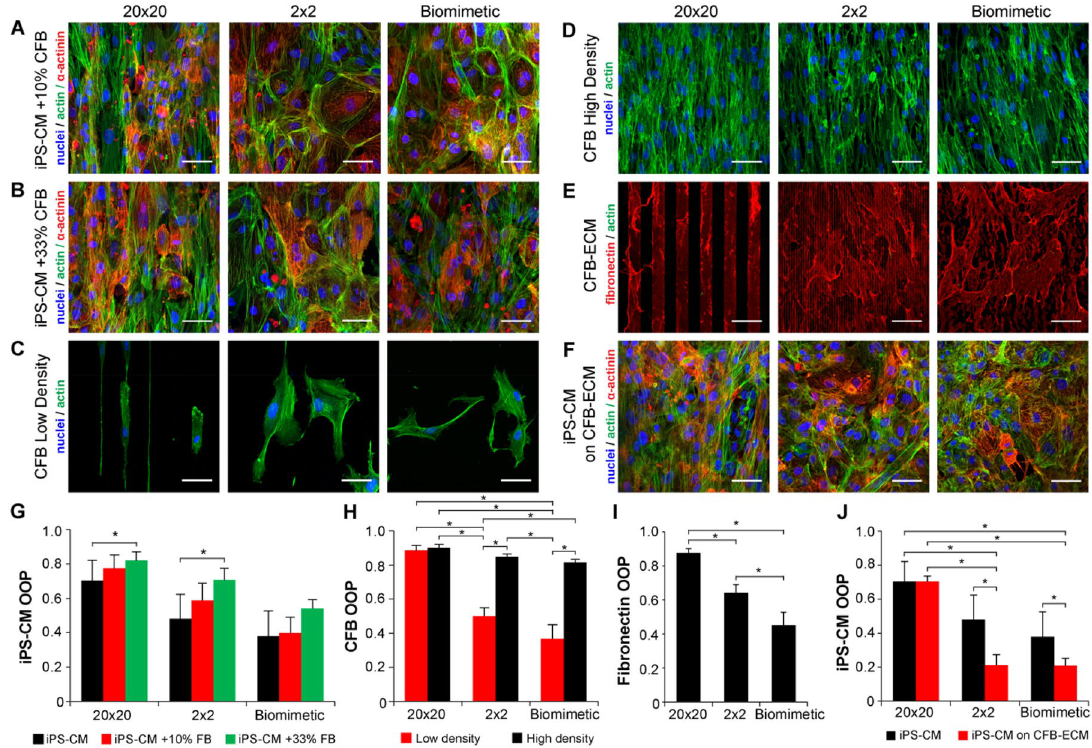
Figure 5. Assessing the role of CFBs on the alignment of iPS-CMs as a function of the fibronectin micropattern. ( A ) Representative images of iPS-CMs with 10% CFBs on the fibronectin micropatterns. CFBs can be distinguished from cardiomyocytes by the lack of α-actinin (red) staining. ( B ) Representative images of iPS-CMs with 33% CFBs on the fibronectin micropatterns. Note the increase in cell alignment relative to ( A ). ( C ) CFBs on the fibronectin micropatterns at low density show pattern-dependent alignment. ( D ) CFBs on the fibronectin micropatterns at high density show alignment on all patterns. ( E ) Fluorescent staining of fibronectin generated by CFBs cultured on the micropatterned substrates, after CFB removal. The 20 × 20 pattern has significantly less CFB-generated fibronectin, likely due to the weaker attachment to the original fibronectin pattern. ( F ) Representative images iPS-CMs cultured on the CFB-generated ECM shown in ( E ). ( G ) Alignment analysis of iPS-CMs on the fibronectin micropatterns with 0%, 10% or 33% addition of CFBs shows increased OOP with increased CFB percentage for all patterns. ( H ) Alignment analysis of CFBs on the fibronectin micropatterns shows that at low density CFB OOP is pattern-dependent, but at high density it is comparably high for all three patterns. ( I ) Alignment analysis of fibronectin generated by CFBs after CFB removal from the surface (CFB-ECM) reveals that for the 2 × 2 and biomimetic patterns, OOP for CFB-ECM is much lower than for the CFB actin cytoskeleton. ( J ) Alignment analysis of iPS-CMs cultured on the CFB-ECM shows decreased OOP for the 2 × 2 and biomimetic conditions compared to the iPS-CM controls cultured on the fibronectin micropatterns alone. Scale bars are 50 µm. ( H ), ( J ) Two-way ANOVA with Tukey post hoc, *indicates p < 0.05, n ≥ 3. ( G ), ( I ) One-way ANOVA with Tukey post hoc, *indicates p < 0.05, n ≥